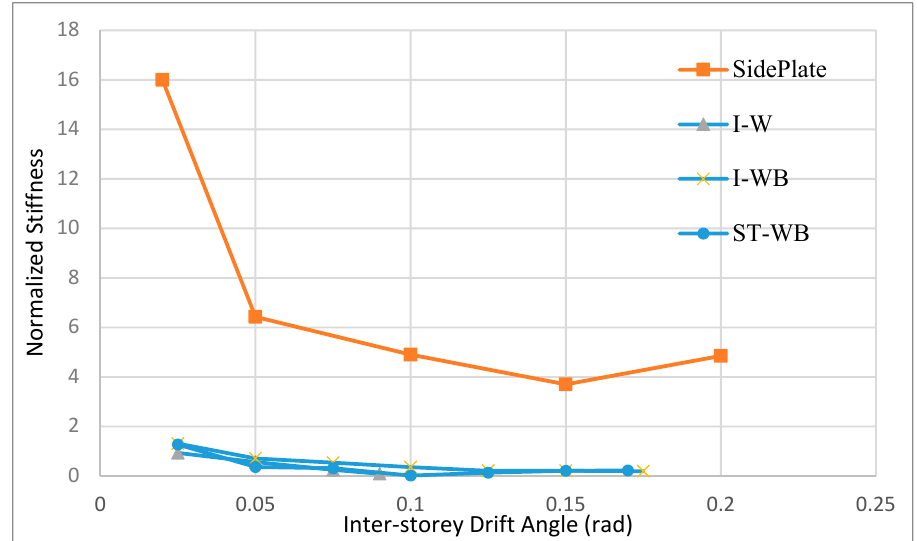
Figure 17. Stiffness degradation versus inter-storey drift angle for fully rigid connections. Figure 17. Sti ff ness degradation versus inter-storey drift angle for fully rigid connections.